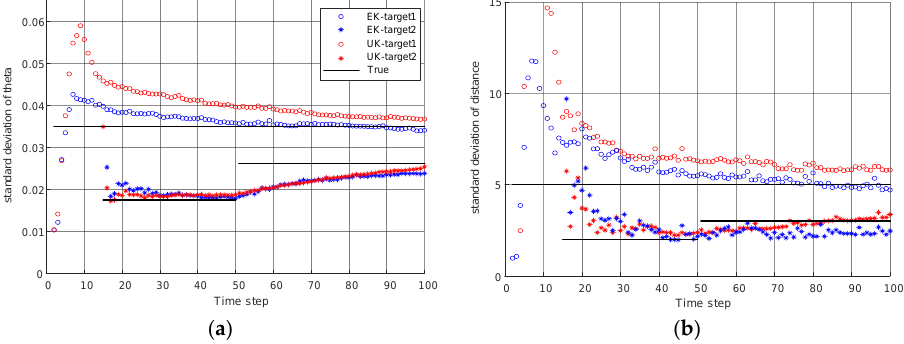
Figure 6. ( a ) Standard deviation estimation of theta of AEK-VB-TPHD and AUK-VB-TPHD. ( b ) Standard deviation estimation of distance of AEK-VB-TPHD and AUK-VB-TPHD ( L =5).